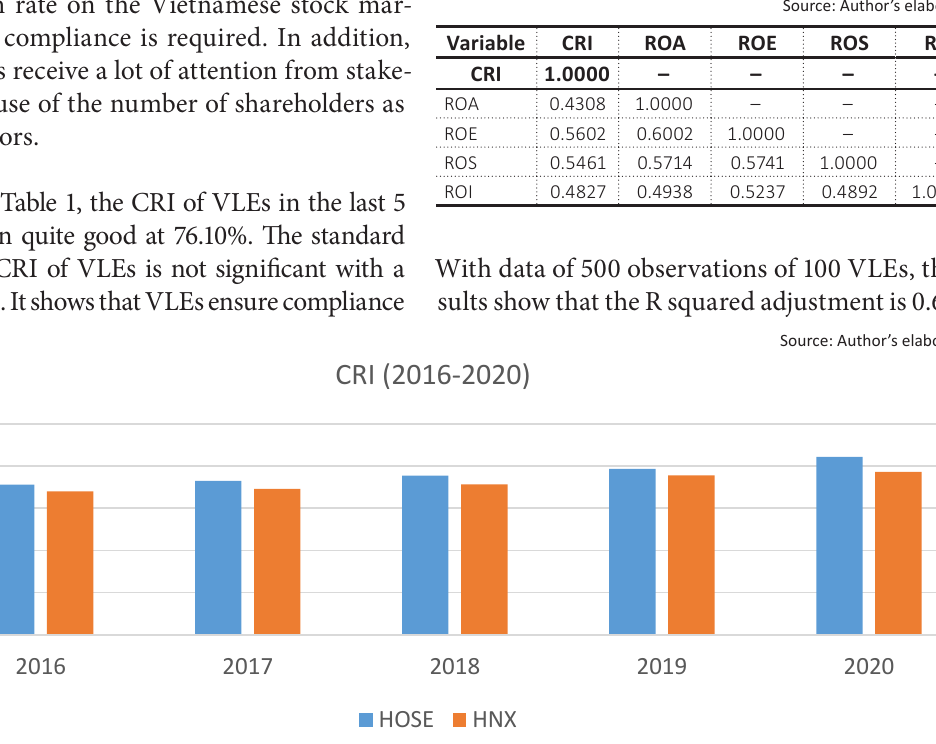
Figure 1. CRI of HOSE and HNX for the period from 2016 to